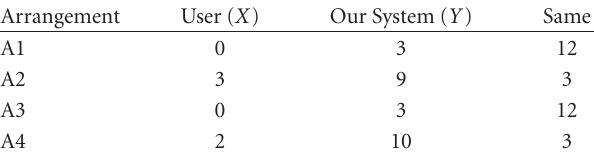
Figure 19: Accuracy of AR Display. Table 3: Subjective evaluation of free ball.